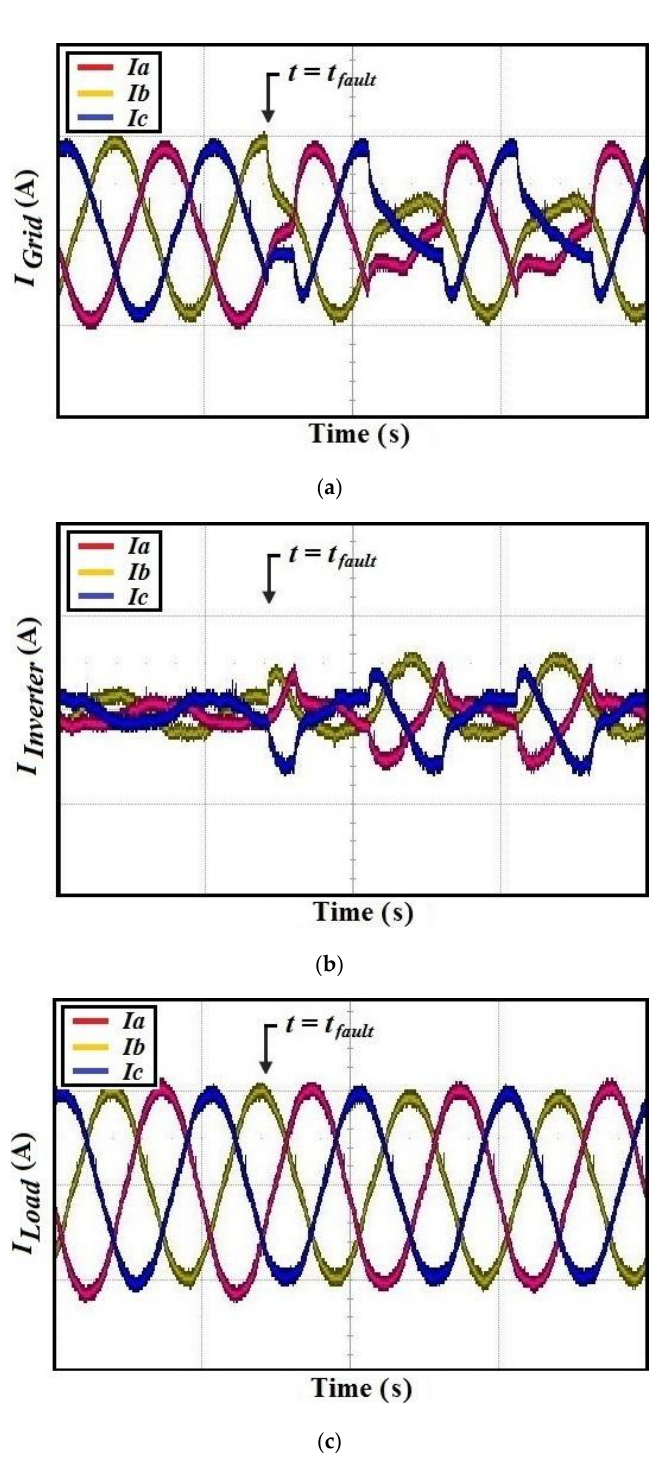
Figure 9. Experimental waveforms of: ( a ) grid currents ( I Grid ); ( b ) inverter currents ( I Inverter ); and ( c ) load currents ( I Load ) with the proposed asymmetrical fault correction technique during a sag for 8 ms after every half cycle (X-axis: 20 ms/div; Y-axis: 1 A/div).